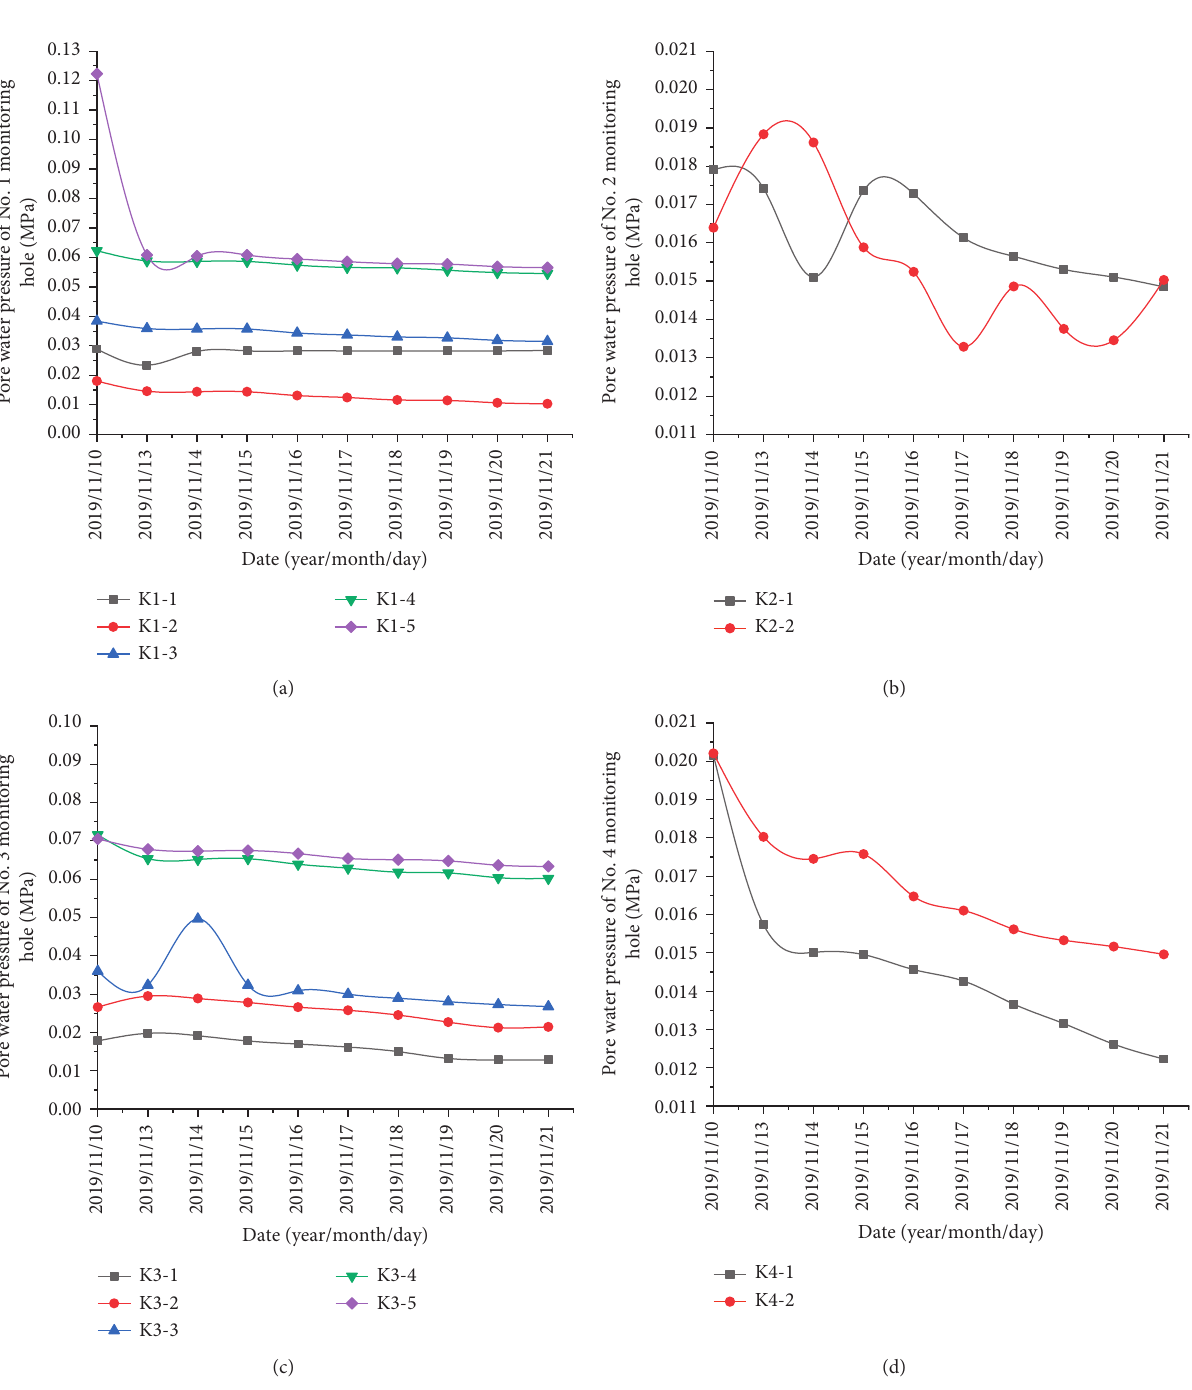
Figure 10: Variation diagram of pore water pressure during Hole 1 jacking. (a) Pore water pressure of No.1 monitoring hole. (b) Pore water pressure of No. 2 monitoring hole. (c) Pore water pressure of No. 3 monitoring hole. (d) Pore water pressure of No. 4 monitoring